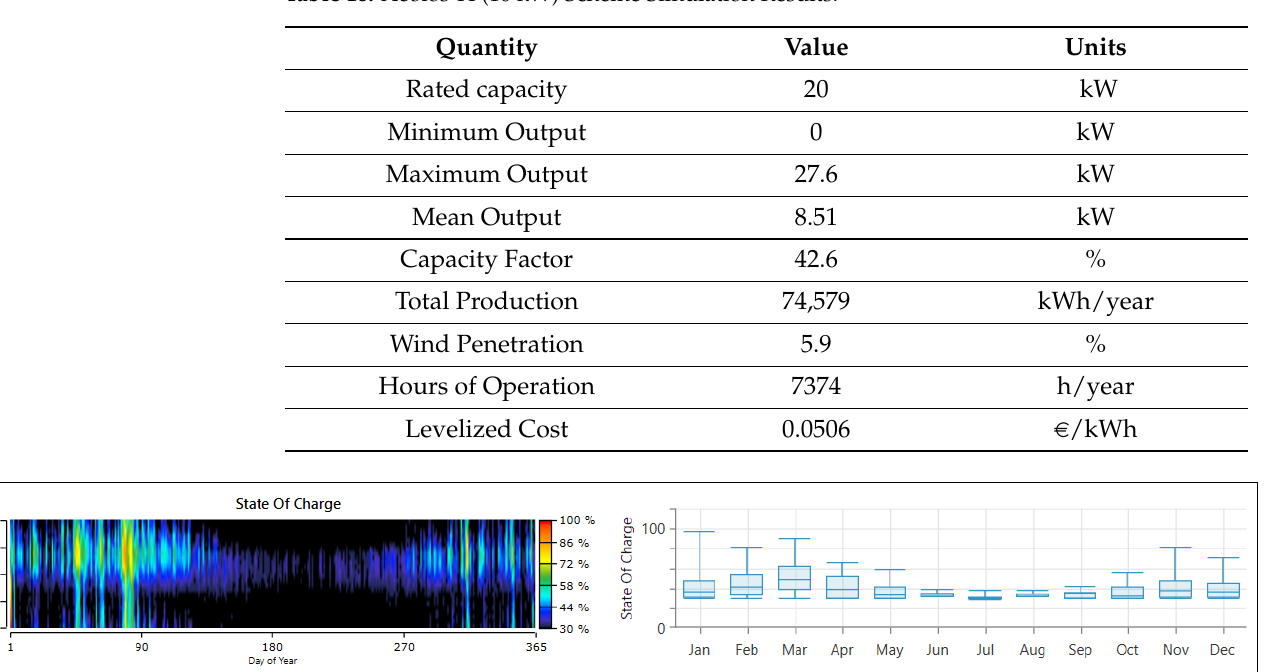
Table 18. Aeolos-H (10 kW) Scheme Simulation Results.